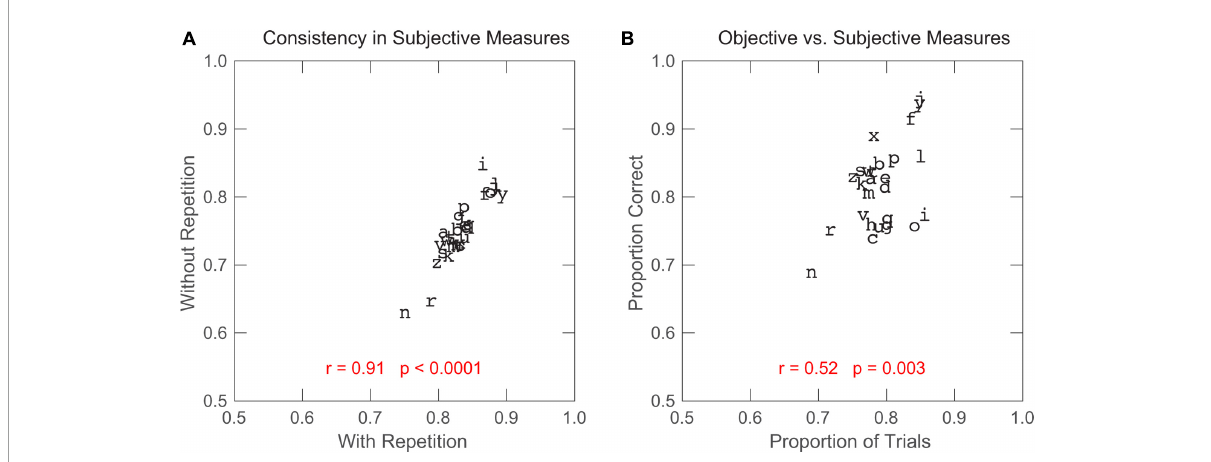
FIGURE6 (A) Subjective measure (proportion of trials with a clear perception of target letter) for the without-repetition group plotted against the subjective measure for the with-repetition group. (B) Objective measure (recognition accuracy of all three letters of trigrams in the post-test) plotted against the subjective measure for the two groups combined. The correlation coefficient and p -value (one-tailed) were calculated for each scatter